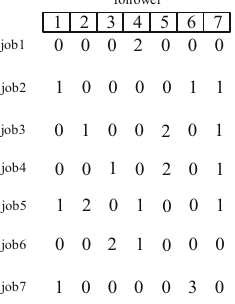
Fig. 6 Temporary set